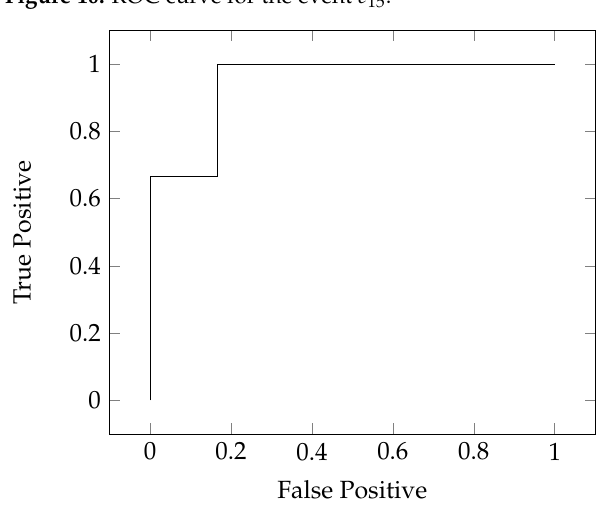
Figure 11. ROC curve for the event e 21